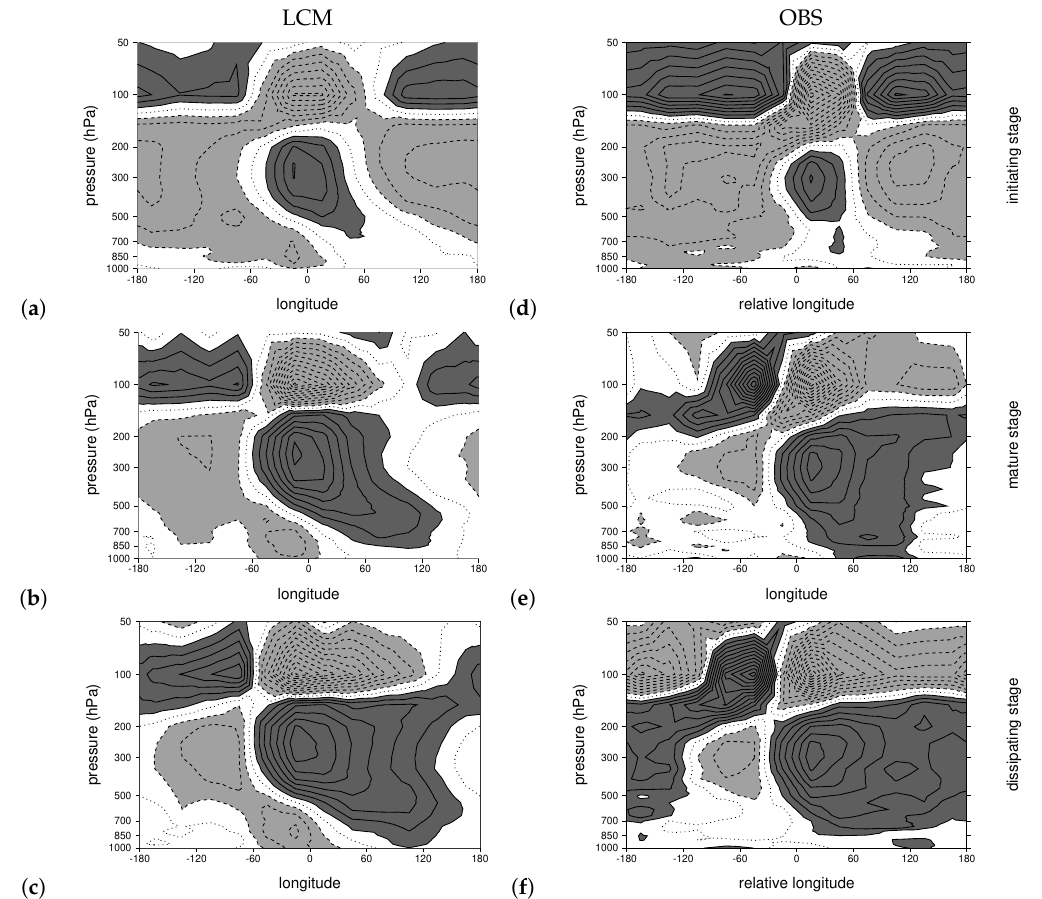
Figure 7. Comparison of observed and modeled composite vertical structure of temperature of the MJO. ( a – c ) Initiating, mature, and dissipating stages in the LCM respectively for the first 30 years of the simulation. ( d – f ) Initiating, mature, and dissipating stages of the observed MJO respectively (from [6]). Temperature perturbations are contoured with a 0.1 K contour interval, with values greater than (less than) 0.1 K ( − 0.1 K) shaded dark (light)